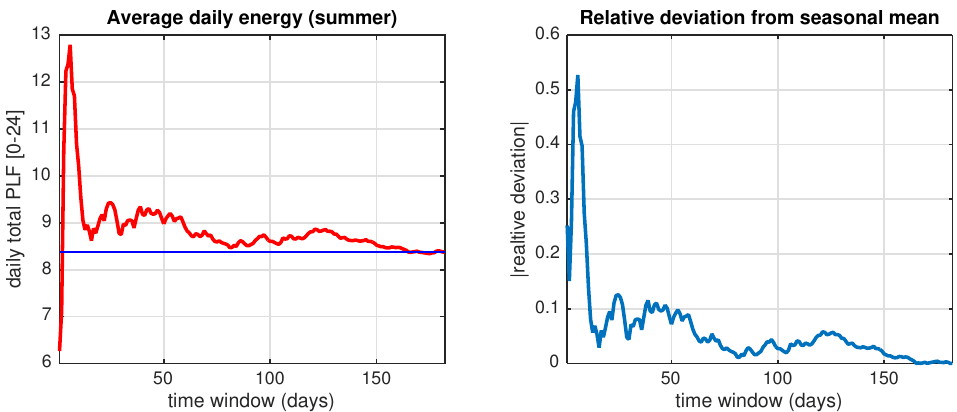
Figure 3. Total and relative deviations of actual PLF with respect to the historical average for summer season (leftmost horizontal blue